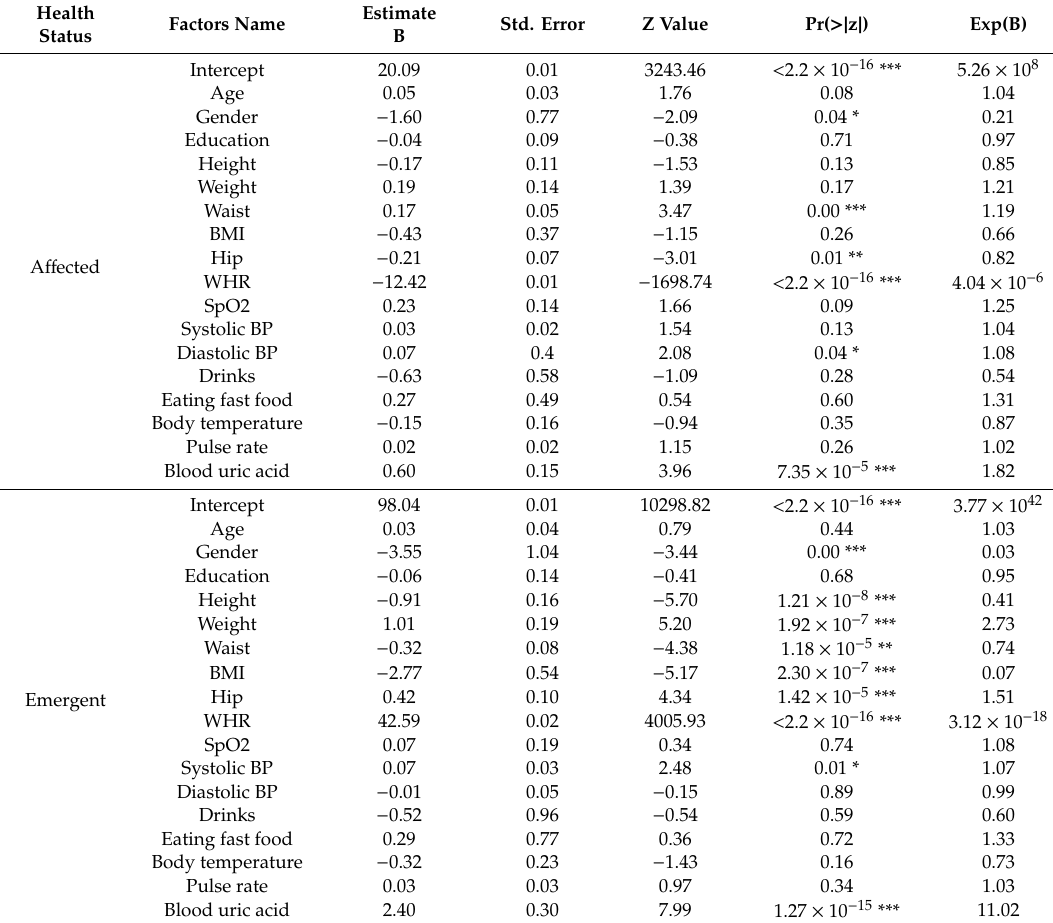
Table 5. Results of the multinomial logistic regression estimation ( n =